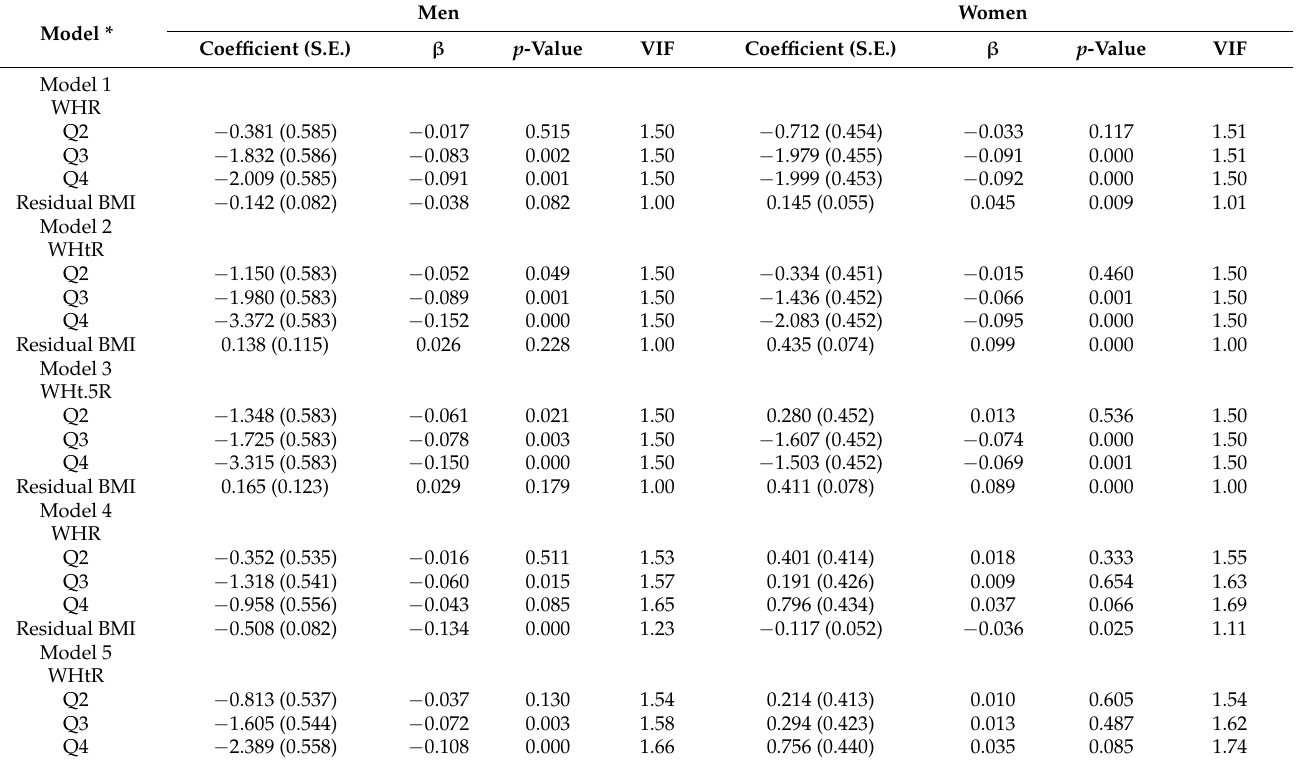
Table 5. Quartile of three waist circumference-related obesity metrics and its association with estimated glomerular filtration rates, compared with the residual body mass